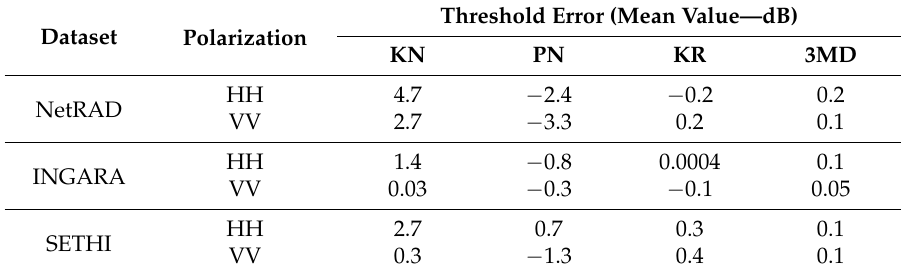
Table 13. Mean values of the threshold error at a CCDF of 10 − 4 for each dataset investigated in this